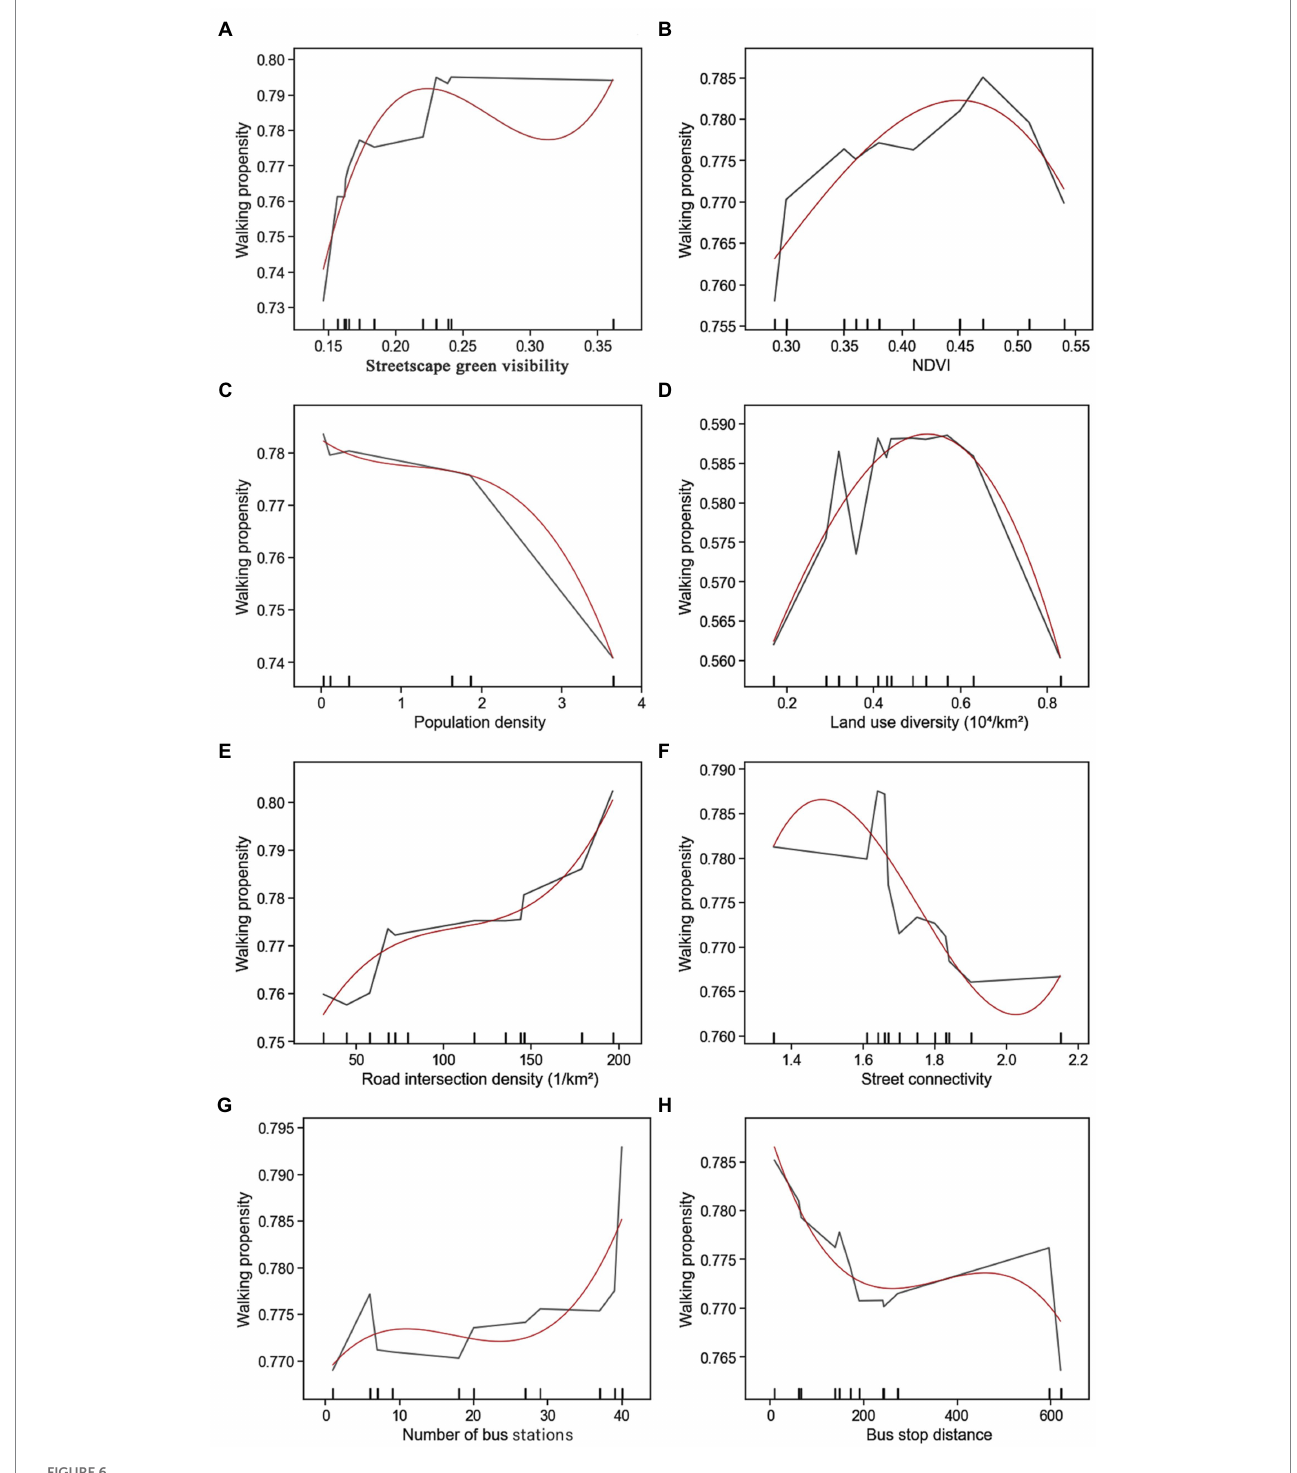
FIGURE 6 (A–H) The nonlinear effect of built-environment characteristics on walking